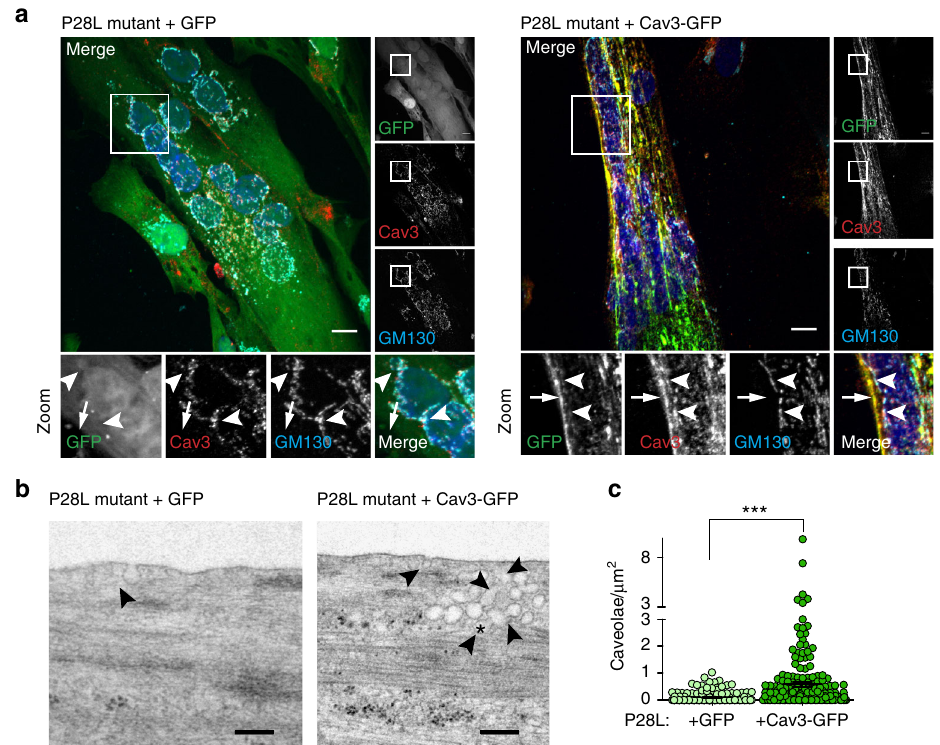
Fig. 5 Expression of WT Cav3 restores the formation of caveolae at the plasma membrane of Cav3 P28L myotubes. a Immuno fl uorescent labeling of Cav3 and Golgi marker GM130 in Cav3 P28L GFP and P28L Cav3-GFP transduced myotubes analyzed by confocal microscopy. Arrows in the inset indicate the plasma membrane and arrowheads indicate the Golgi complex. b Electron micrographs of Cav3 P28L GFP and P28L Cav3-GFP transduced myotubes. Caveolae and interconnected caveolae are indicated with arrowheads and asterisks, respectively. c Quanti fi cation of the number of caveolae/ µ m 2 in b . a Scale bar = 10 µ m. b Scale bar = 200 nm. Reproducibility of experiments: a Representative pictures of 3 experiments. b Representative pictures quanti fi ed in c (number of analyzed regions: P28L GFP = 169, P28L Cav3-GFP = 182; total screened area: P28L GFP = 1405 µ m 2 , P28L Cav3-GFP = 1349 µ m 2 ). Mean value ± SEM. Statistical analysis with a two-tailed unpaired t test; *** P < 0.0001; ns non-signi fi